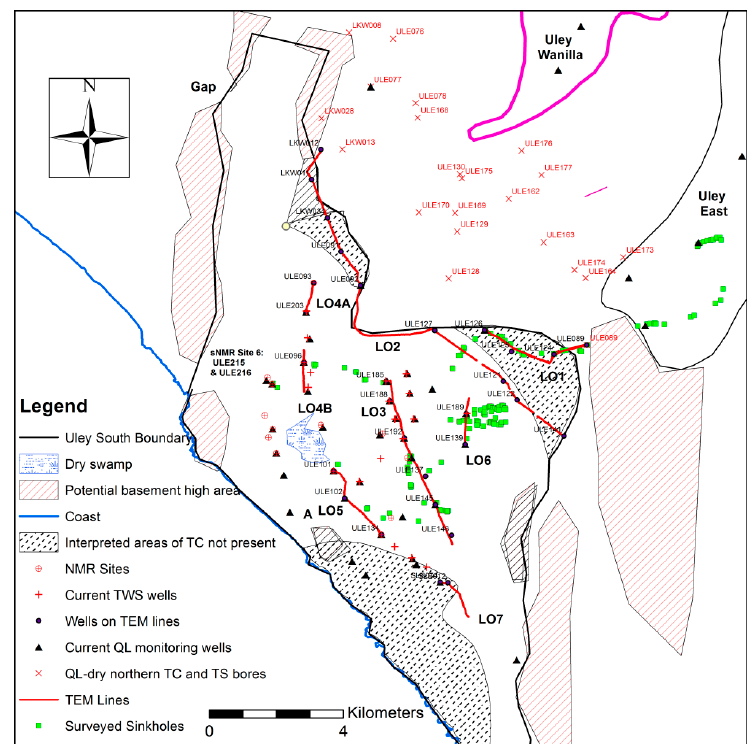
Figure 5. Dry northern QL bores and TEM lines LO1–LO7.